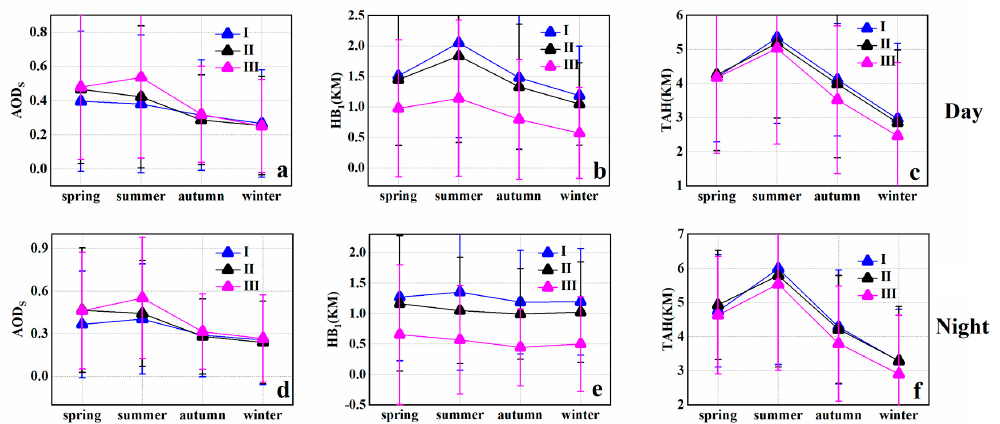
Figure 14. Seasonal variation in the optical and physical properties of aerosol layer over Saudi Arabia (regions I, II, and III) from 2007 to 2019. Where ( a , d ) represent AOD S , ( b , e ) represent HB 1 , and ( c , f ) represent TAH.